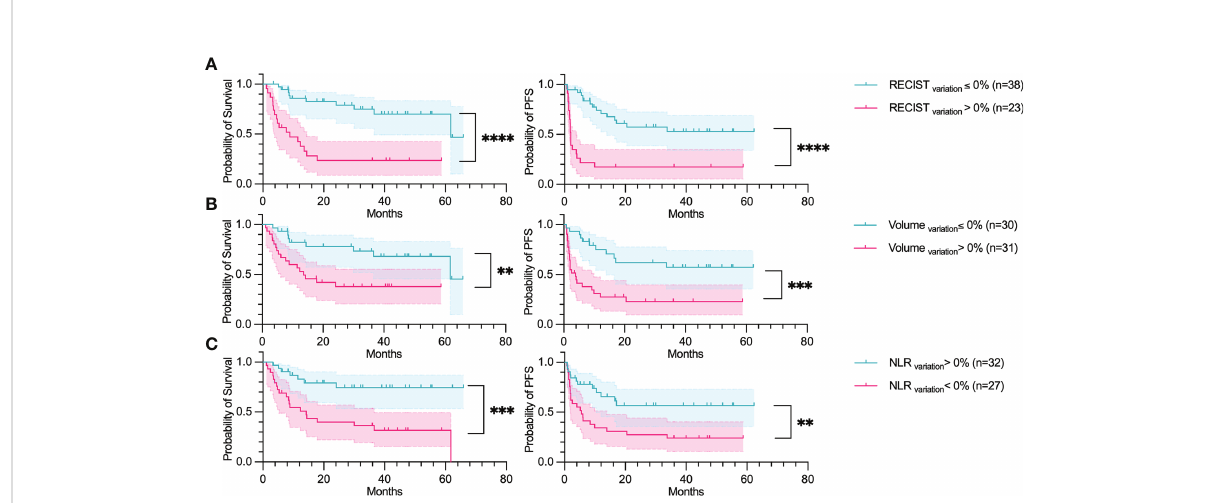
FIGURE 4 RECIST variation , Volume variation and NLR variation predicts OS and PFS. Overall survival and Progression-free survival plotted using a Kaplan-Meier estimation with their respective con fi dence intervals (95%). The parameters studied are: (A) The increase in the sum of RECIST diameters (RECIST); (B) Increase of total tumor volume (Volume); and (C) Increase of neutrophil-to-lymphocyte ratio (NLR). For Kaplan – Meier estimation, tick marks represent data censored at the time of the last imaging assessment and statistical analyses were performed using Log-rank (Mantel- Cox) test. Symbol signi fi cance: * p ≤ 0.05; ** p ≤ 0.01; *** ≤ 0.001, **** ≤